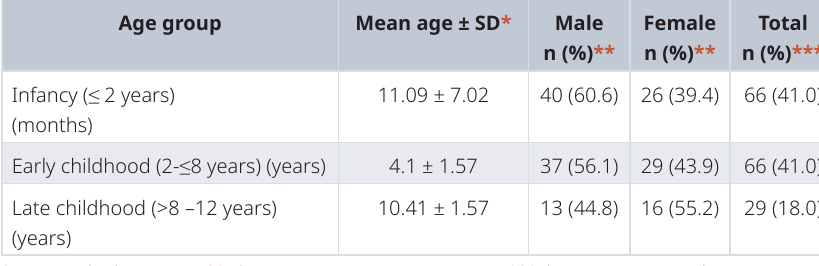
Table 1. Characteristics of the study